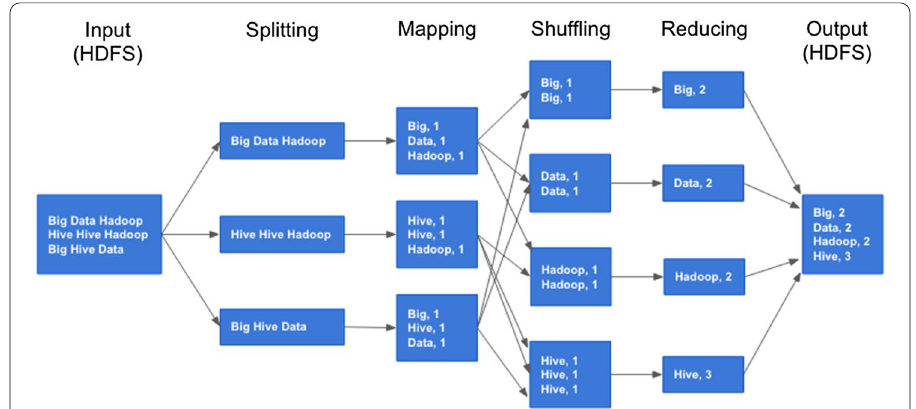
Fig. 7 An example of data flow in